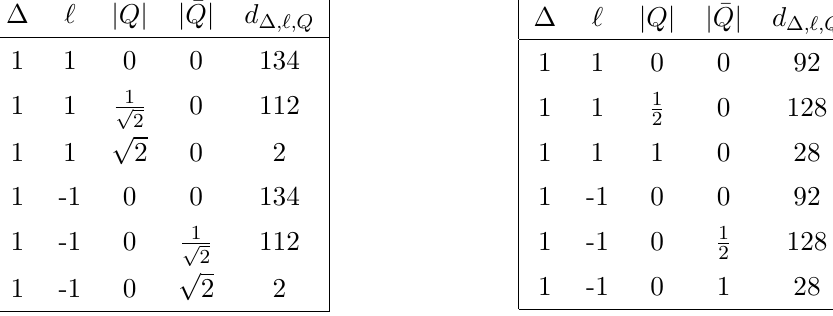
Table 2 . Occupation numbers from a linear programming analysis. The left table assumes states Z , whereas the right assumes Q 2 1 at Q 2 1 p 2